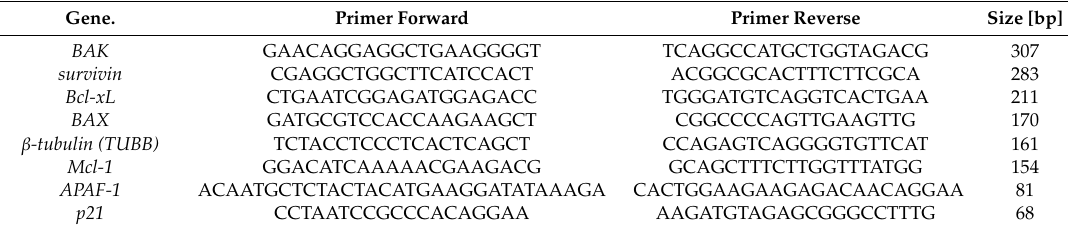
Table 5. Primer sequences for PCR.